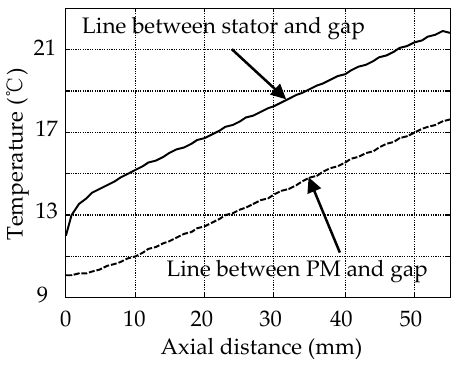
Figure 13. Temperature curves along the axial direction.